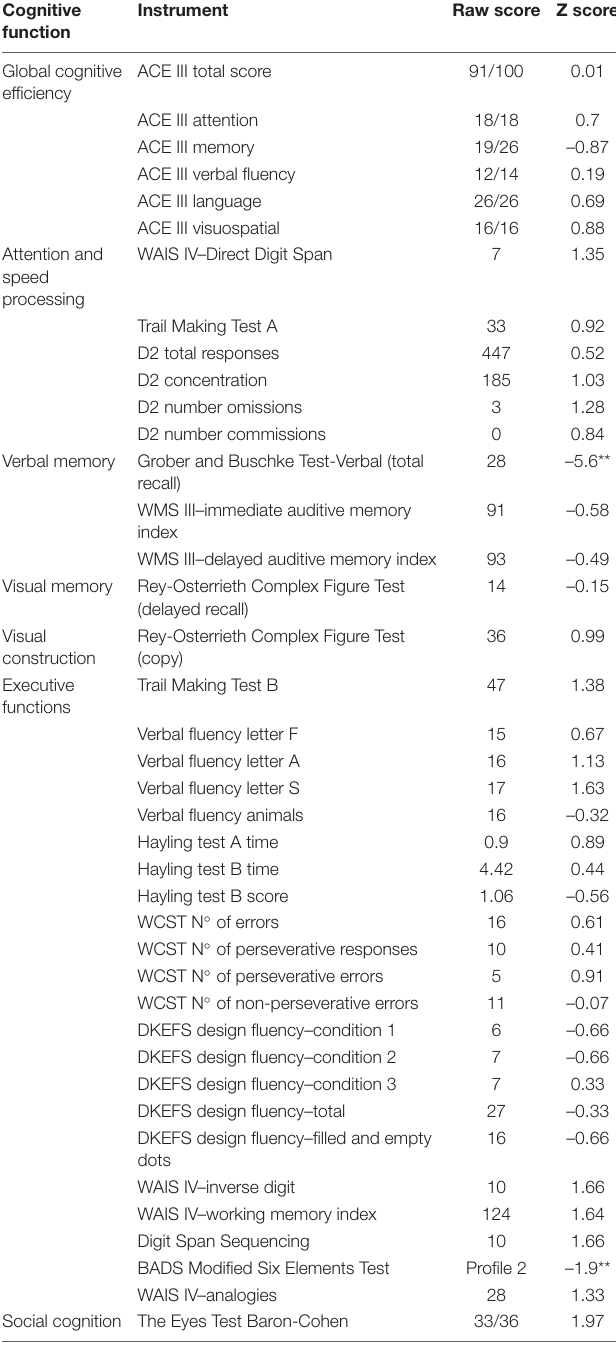
TABLE 1 | Mrs. B neuropsychological